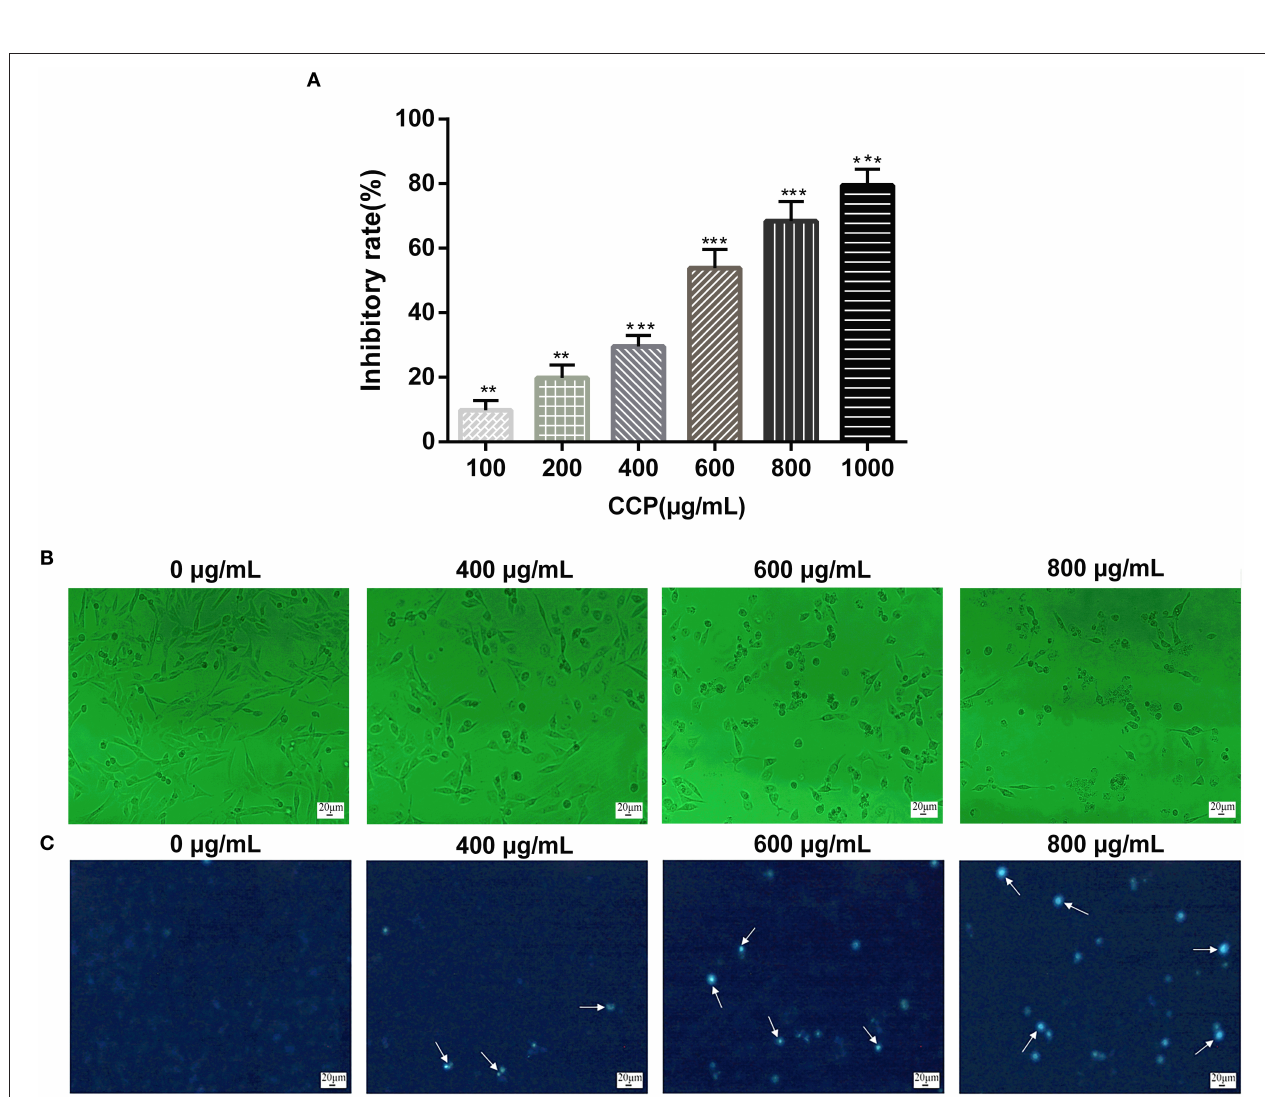
FIGURE 4 | (A) Effect of CCP on MDA-MB-231 cells proliferation. The morphological characteristics (B) and nuclear morphological changes (C) of cells treated with CCP. The white arrows represent apoptotic nuclear fragments. ** P < 0.01 and *** P < 0.001 vs. control group.